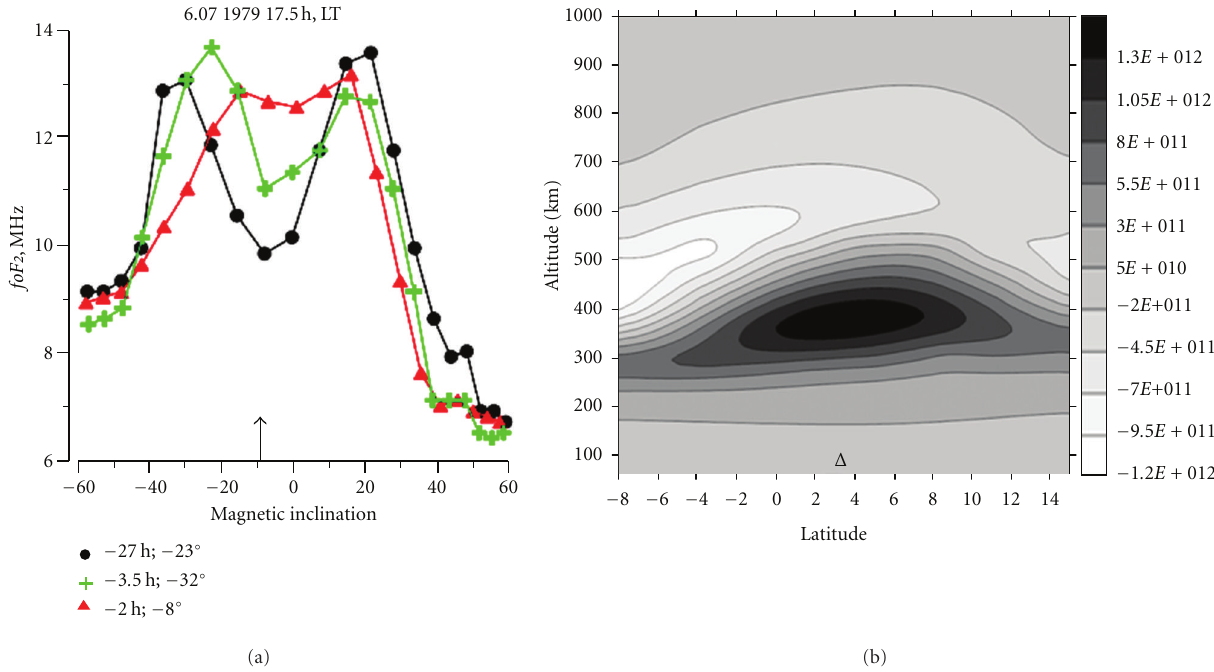
Figure 2: (a) consecutive passes of Intercosmos-19 satellite over equatorial anomaly. In figure legend are shown time before earthquake and longitudinal distance of the satellite orbit from the epicenter longitude sign “ − ” indicates satellite pass eastward and sign “+” pass westward from the epicenter longitude; (b) tomographic reconstruction of the di ff erence of the vertical distribution of electron density between July 6 and July 5 1979 (red and black lines at the left